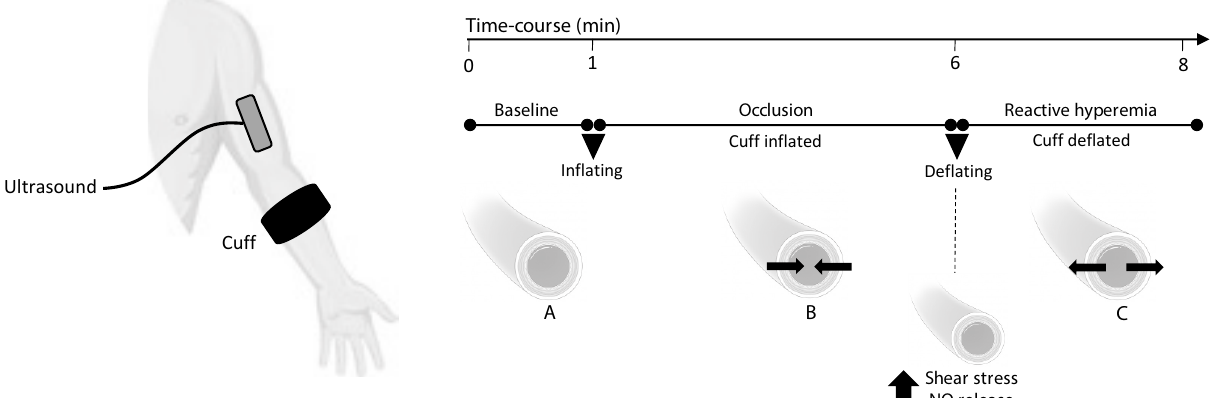
Figure 1. Flow-mediated dilation (FMD) is non-invasive technique using high-resikution ultrasound on the brachial artery composed by three phases. NO: nitric oxide A. After rest time, baseline arterial diameter should be performed. B. The stimulus for the FMD test depends on vascular occlusion period. At this moment, the cuff is inflated above the systolic values for 5 minutes. C. The measurement of arterial diameter after the cuff release (peak of response between 45 to 60 seconds), characterizing the hyperemic period.